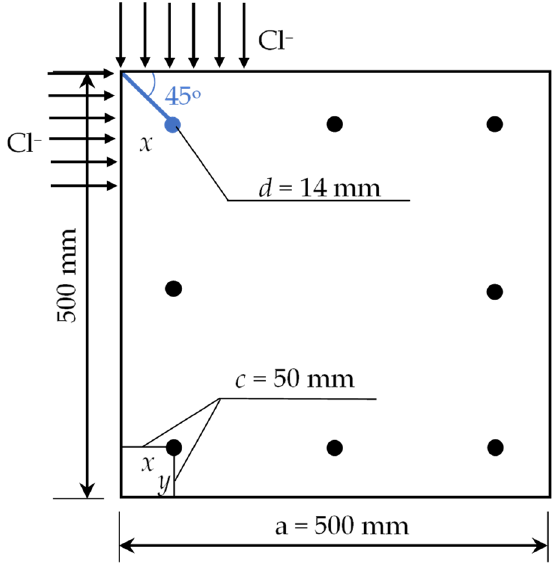
Figure 2. Configuration of RC square pile. Table 1. Variables in t 1 computation.